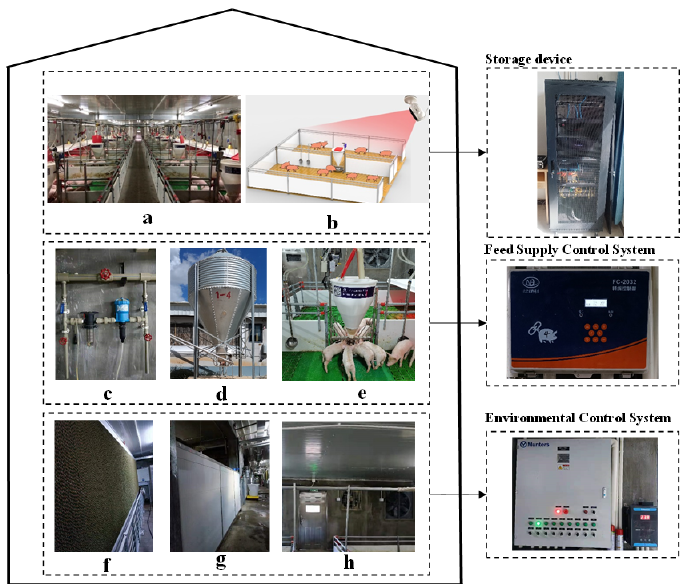
Figure 1. Overall dimensions of the pig housing. ( a ) Inside the pig house. ( b ) Camera shooting position. ( c ) Water supply pipeline. ( d ) Feed tower. ( e ) Faucet and feeding equipment. ( f ) Wet curtain. ( g ) Baffle. ( h )